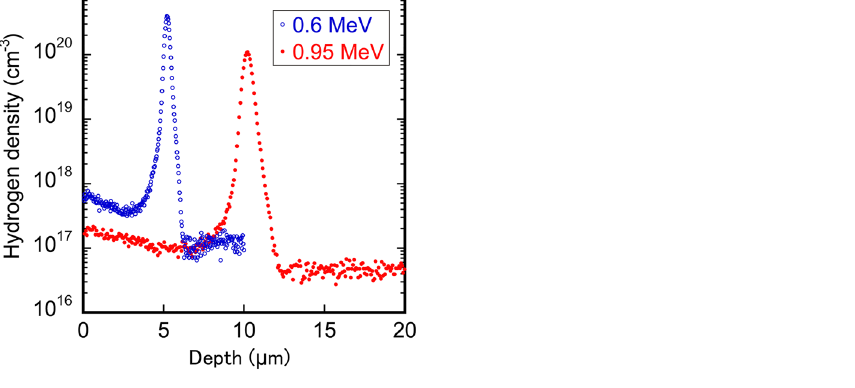
Figure 1. Depth profile of hydrogen density for specimens subjected to proton fluence of 1 × 10 16 cm −2 measured by